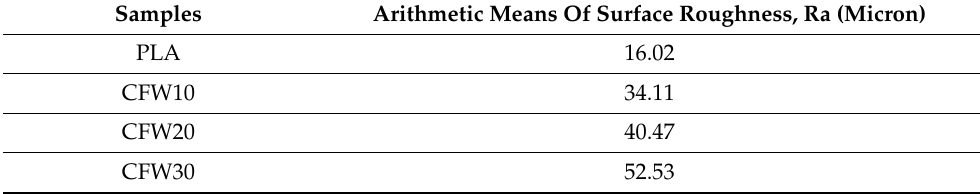
Figure 7. Fracture morphology and roughness analysis of materials: ( a ) PLA; ( b ) PLA/CFW10; ( c ) PLA/CFW20; ( d ) PLA/CFW30. Table 2. Arithmetic means surface roughness of the fracture .